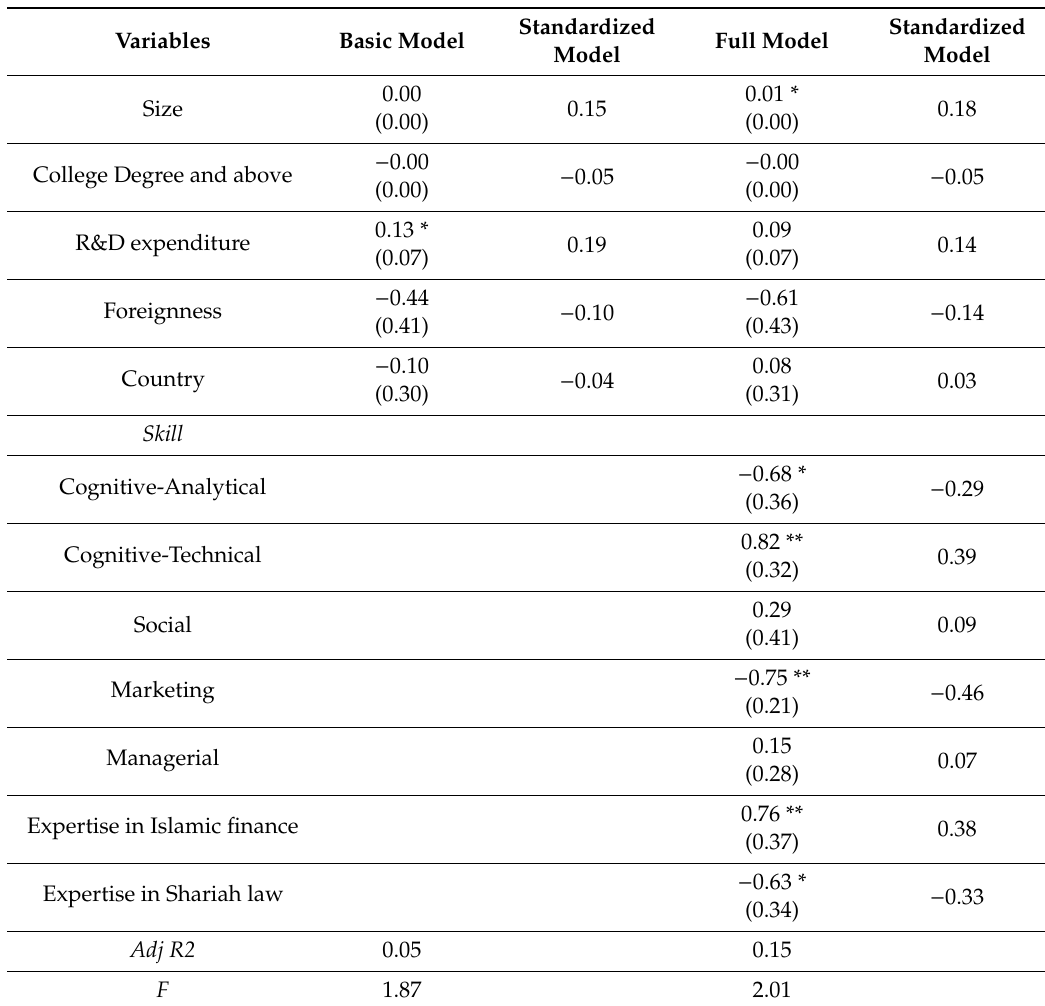
Table 5. Ordinary Least Squares (OLS) regression analysis for innovation and